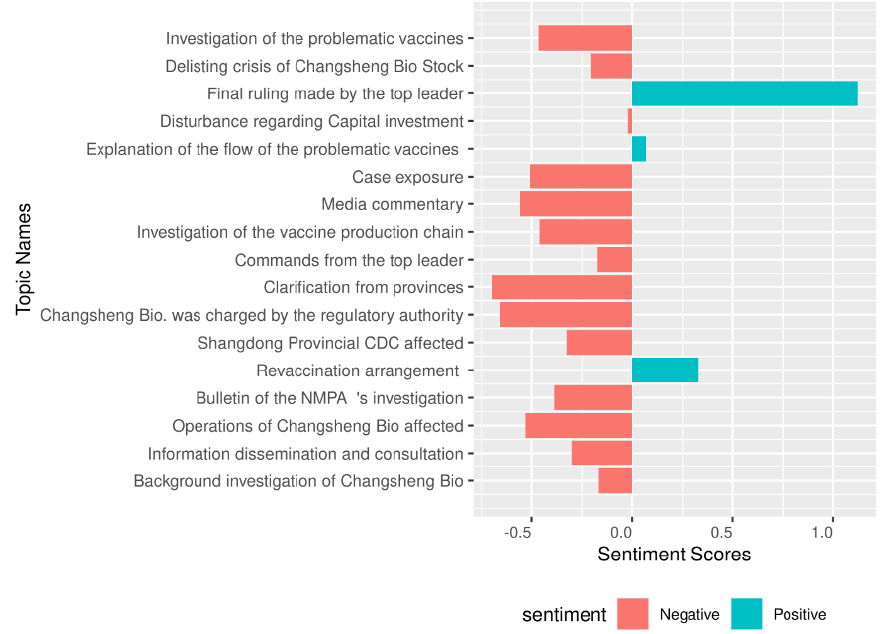
Figure 6. Sentiment scores of the 17 topics.